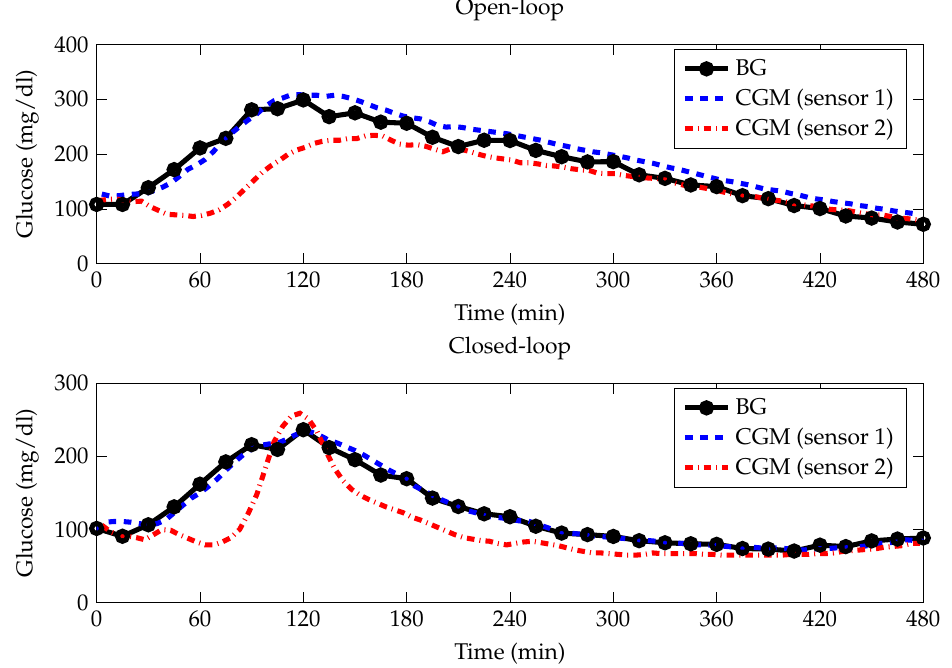
Figure 1. Representative example of the dataset employed in this paper. BG references frequently collected every 15 ± 5 min for 8 h (linearly interpolated by a straight line), and CGM time series (other lines) are measured simultaneously using n = 2 second generation Medtronic Paradigm Veo Enlite sensors (Northridge, CA, USA) in a type 1 diabetic patient during an open loop (top) and closed loop (bottom) meal test. BG, blood glucose; CGM, continuous glucose